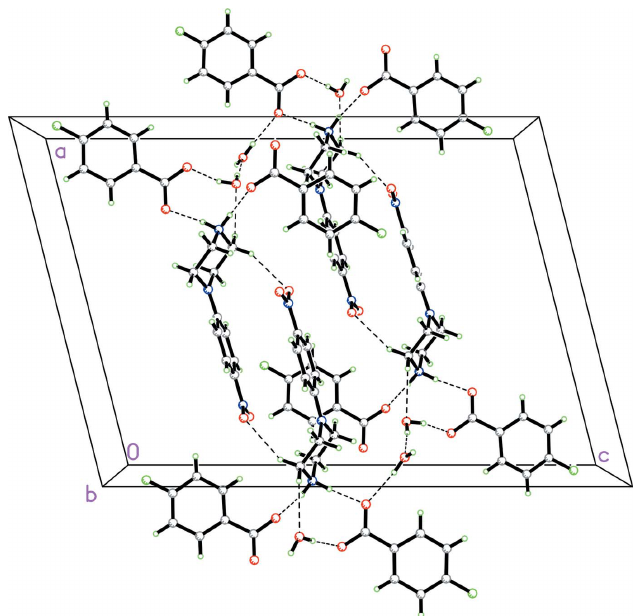
Figure 6 Packing diagram for 2 showing the complex three-dimensional array of hydrogen bonding involving both R 2 (middle left in diagram with ring B on right and ring C on left) and R 3 motifs between rings C and D (ring D on upper left of diagram) as well as one water molecule.